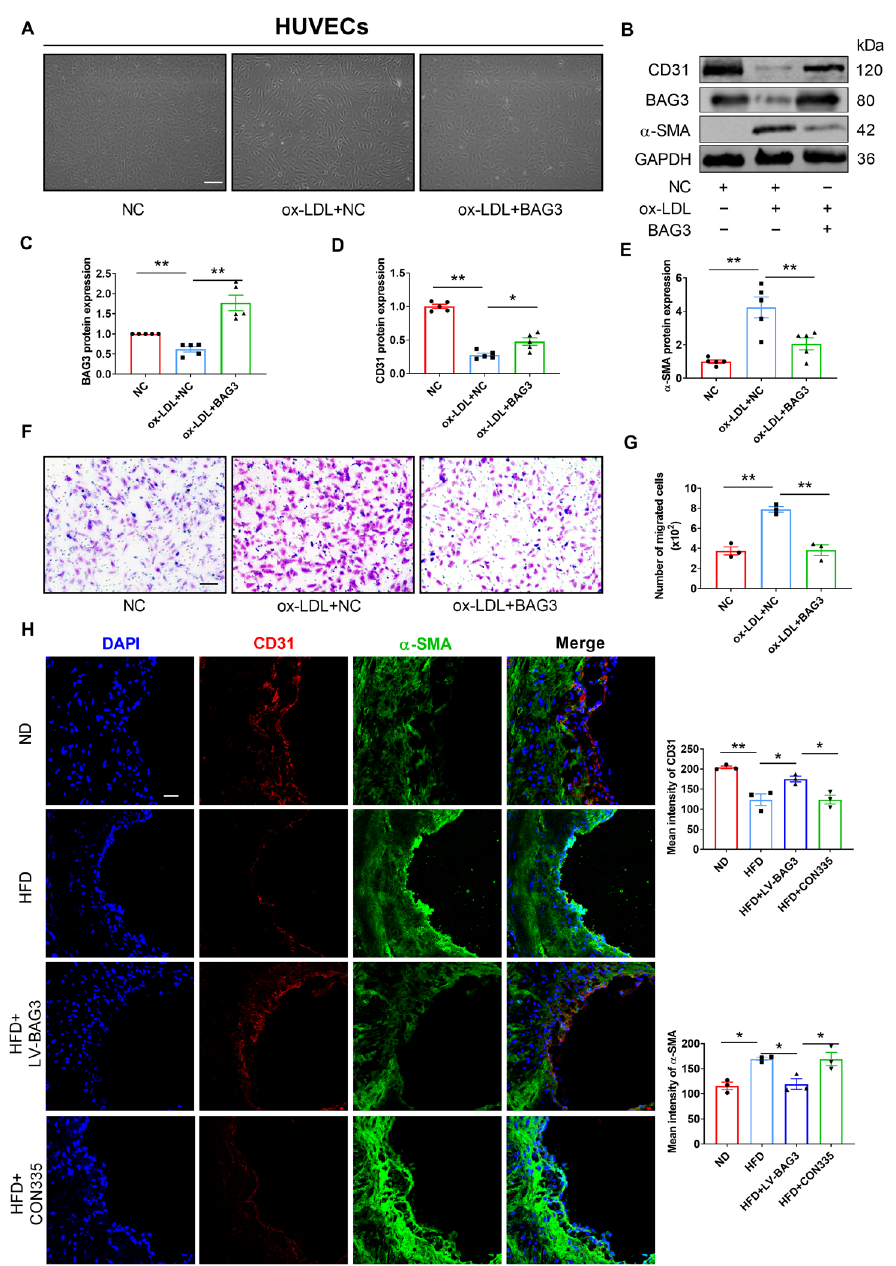
Figure 2. BAG3 prevents EndMT in vivo and vitro. ( A ) Morphological changes post the indicated treatments were observed under the microscope (scale bar indicates 100 µm) ( n = 3). ( B – E ) CD31, BAG3 and α -SMA protein expressions were detected using Western blotting. Fold changes are shown ( n = 5). ( F , G ) Transwell cell invasion assay was performed to analyze the migration ability of cells (scale bar indicates 100 µm) ( n = 3). ( H ) Representative images of double-fluorescent staining with α -SMA (green) and CD31 (red) in the endothelium. The nuclei were stained blue with DAPI. (scale bar indicates 25 µm) ( n = 3). The data are presented as the mean ± S.E.M. * p < 0.05, ** p < 0.01.